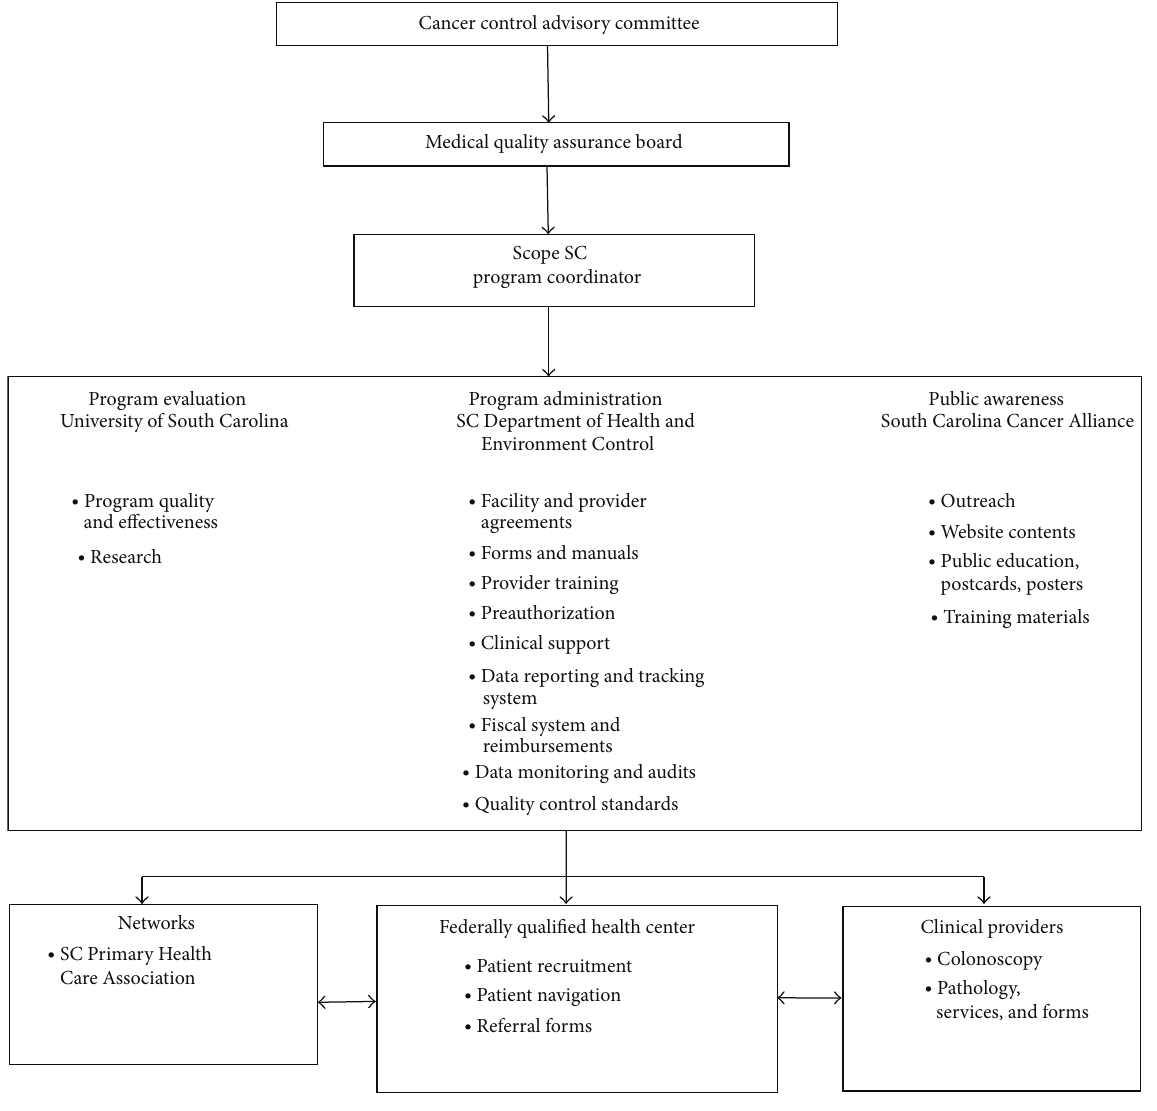
Figure 1: SCOPE SC program organization